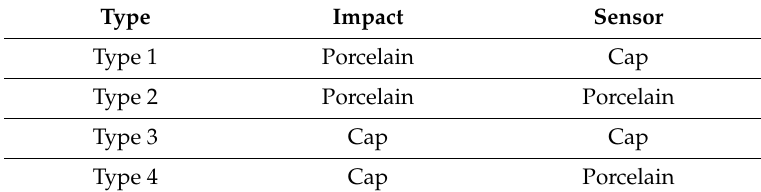
Table 2. Type according to impact hammer and sensor position.